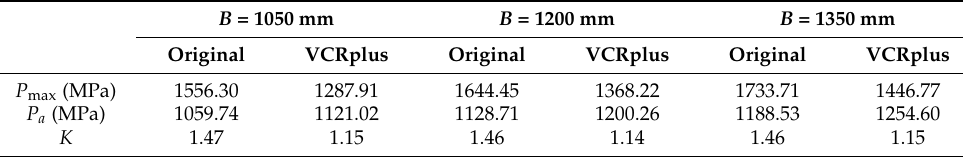
Table 7. The coefficient, K , at different rolling forces, q . q = 10